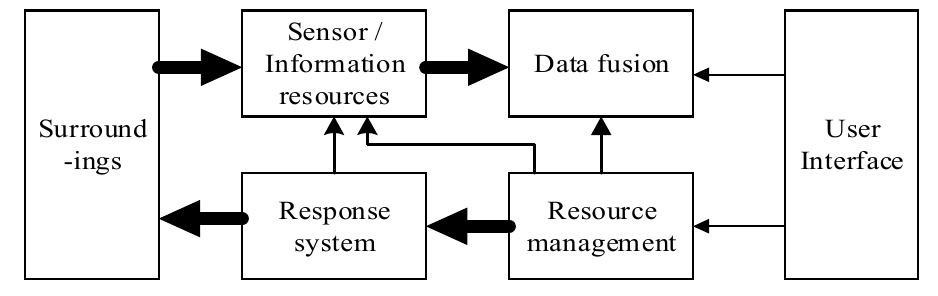
Figure 1. Typical application of information fusion.